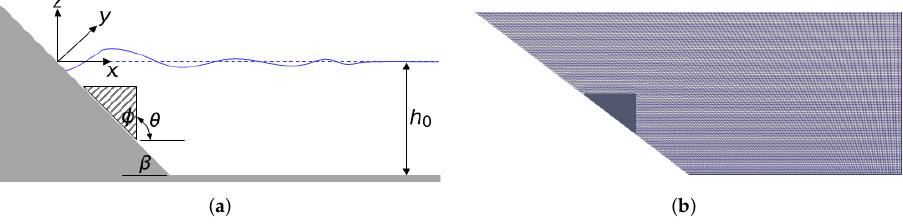
Figure 1. ( a ) Schematic (not drawn to scale) of the numerical wave tank: a solid slide moving downhill on a sloping beach connected to a region of constant depth h 0 . β is the beach slope, φ denotes the slide front angle [68], and θ shows the included angle formed by the slide front face and the still free surface. Origin of the coordinate system is set at the initial shoreline. ( b ) The computational domain and a sample numerical mesh. No-slip condition is required on all boundaries, except at the top boundary open to free